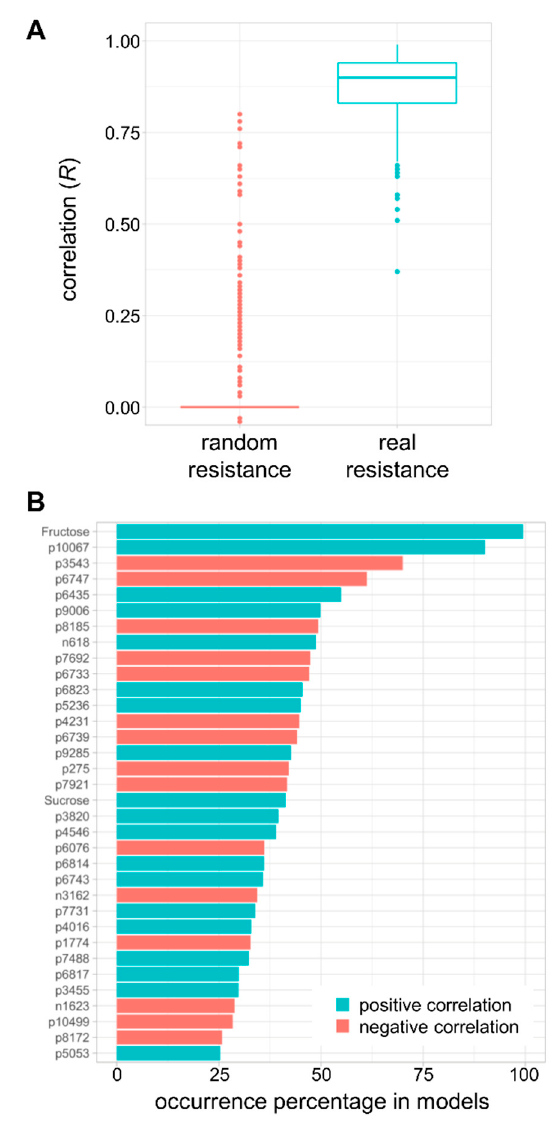
Figure 6. Prediction of biotic resistance from metabolic markers. ( A ) correlation between predicted and measured resistance based on generalised linear models. ( B ) occurrence (%) of the metabolic markers in the models that showed a positive or negative correlation with the resistance to fruit pathogens. Details of untargeted markers are presented in Table